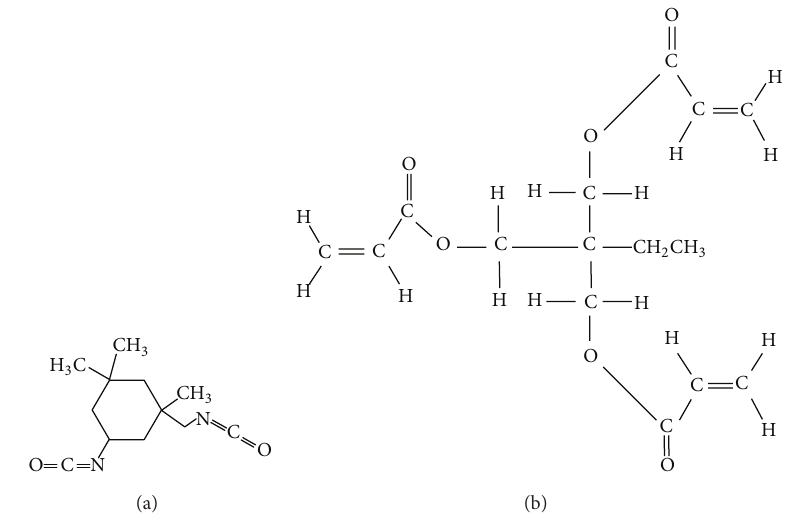
Figure 1: Molecular structure of (a) IPDI and (b) TMPTA.